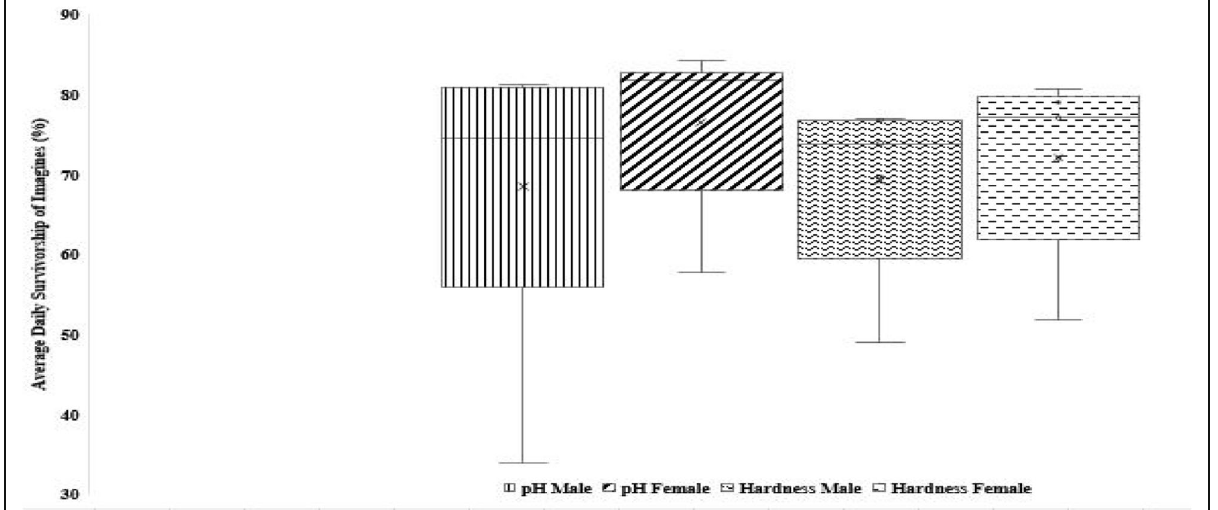
Fig. 3 Biplots of effects of water pH and hardness on daily survivorship of male and female adult life stages of Culex quinquefasciatus